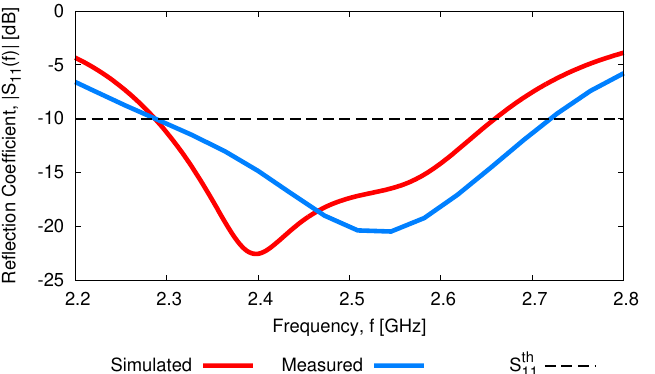
Figure 20. Experimental Assessment —Comparison between the simulated and measured reflection coefficients at the antenna input